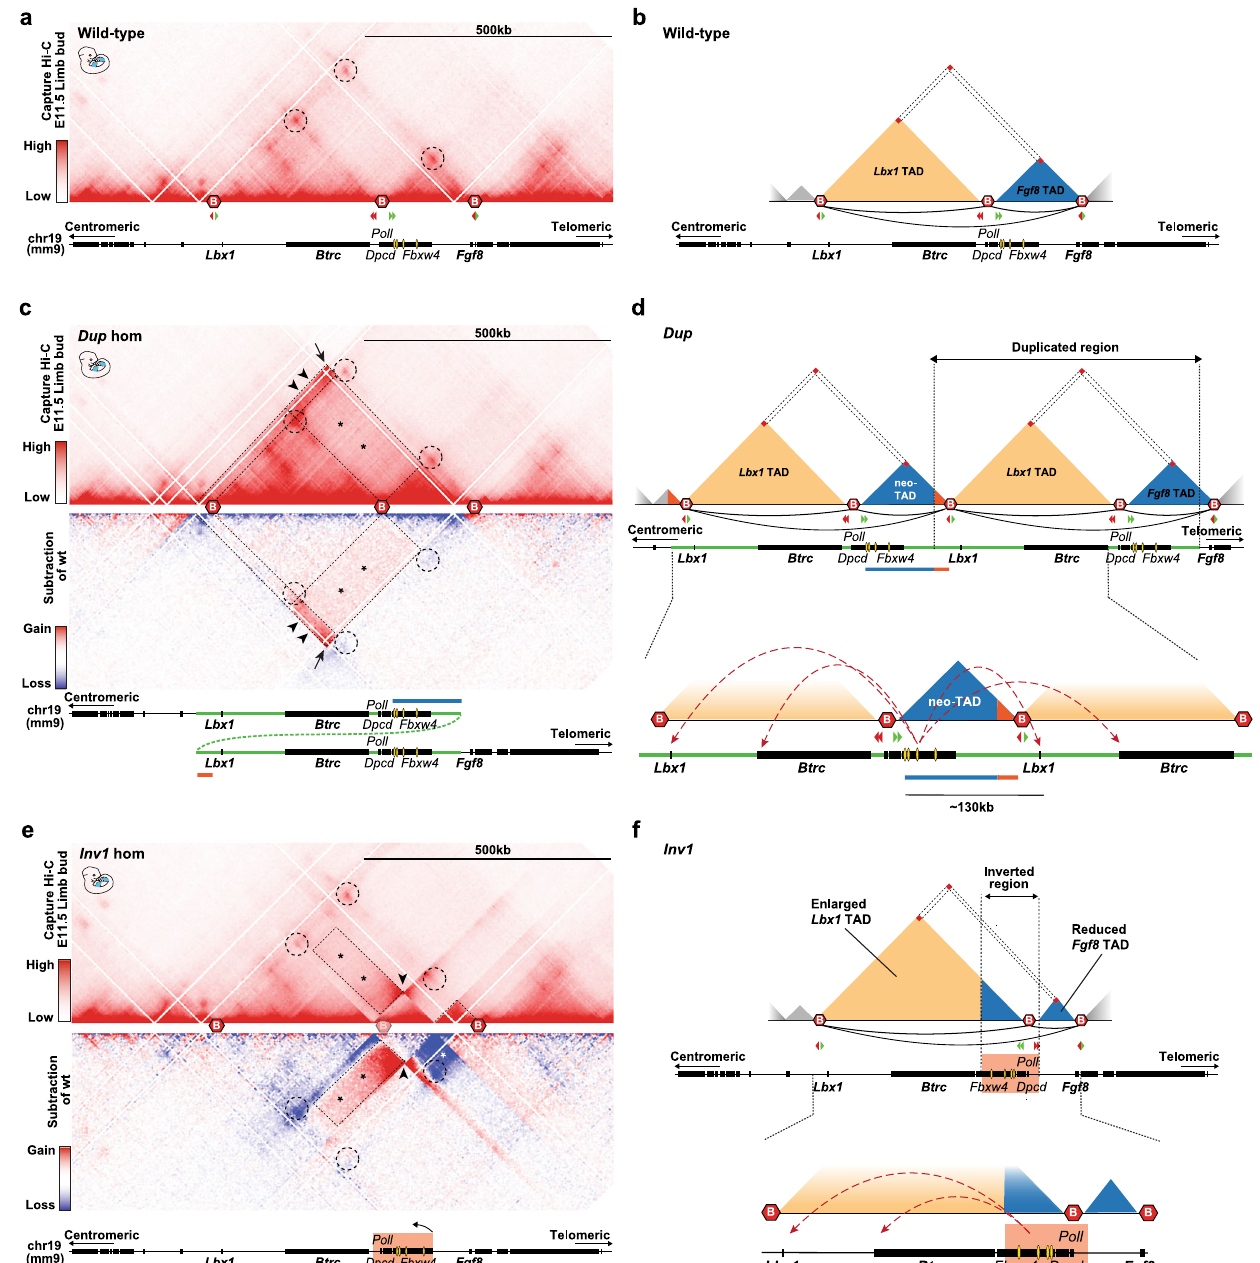
Fig. 2 | Ectopic 3D interactions upon structural rearrangements at the Lbx1 / Fgf8 locus. a Wild-type E11.5 mouse limb buds cHi-C (merged signal of n =3 biological and 1 technical replicates). Red hexagons indicate boundaries, dashed circles highlight boundaries interactions. CTCF binding sites orientation and sche- maticofthelocusarebelow.Yellowovalshighlight Fgf8 AERenhancers. b Schematic of the wild-type con fi guration. Lbx1 TAD in yellow, Fgf8 TAD in blue. Red squares highlight boundaries interactions. CTCF binding sites orientation, interactions between convergent CTCF and schematic of the locus are below. c cHi-C (merged signal of n =3 biological and 1 technical replicates) of homozygous Dup E11.5 mouse limb buds. Subtraction map between wild-type and Dup interac- tions is shown in mirror view. Dashed circles indicate positions of preserved wild- type boundaries interactions, black arrow highlight the new contact re fl ecting the duplication breakpoints. Black arrowheads indicate gain of contacts between the region containing the Fgf8 AER enhancers (blue bar in the locus schematic below) andtheregion fl ankingthecentromericsideofthe Lbx1 TADboundary(orangebar). Asterisks highlight the rectangular dashed area showing increased interactions